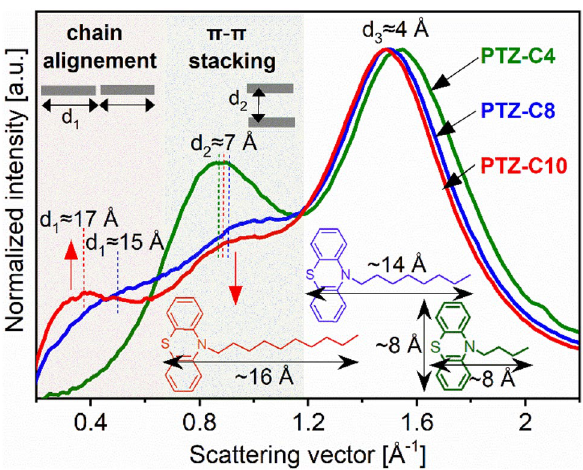
Figure 1. Comparison of the XRD patterns for PTZ-C4, PTZ-C8, and PTZ-C10 in the low-scattering vector range arising mainly due to the intermolecular structure. The presence of two pre-peak features for PTZ-C10 is the fingerprint of two types of intermolecular ordering, parallel π – π stacking of cores and longitudinal organization of chains. The average dimensions of molecules and intermolecular periodicities calculated from the positions of the diffraction peaks were